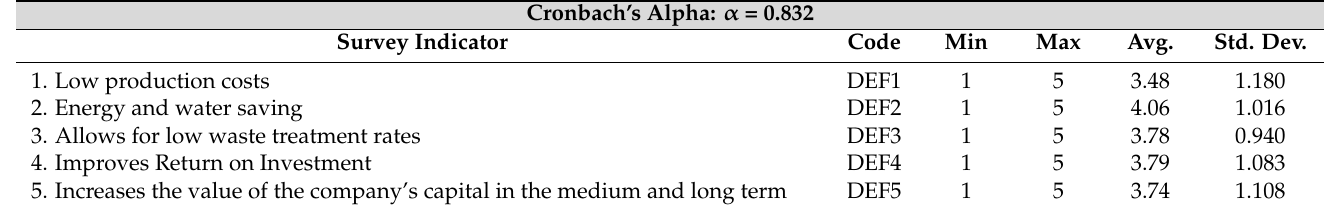
Table 4. Descriptive Statistics of “Economic and Financial Performance” survey